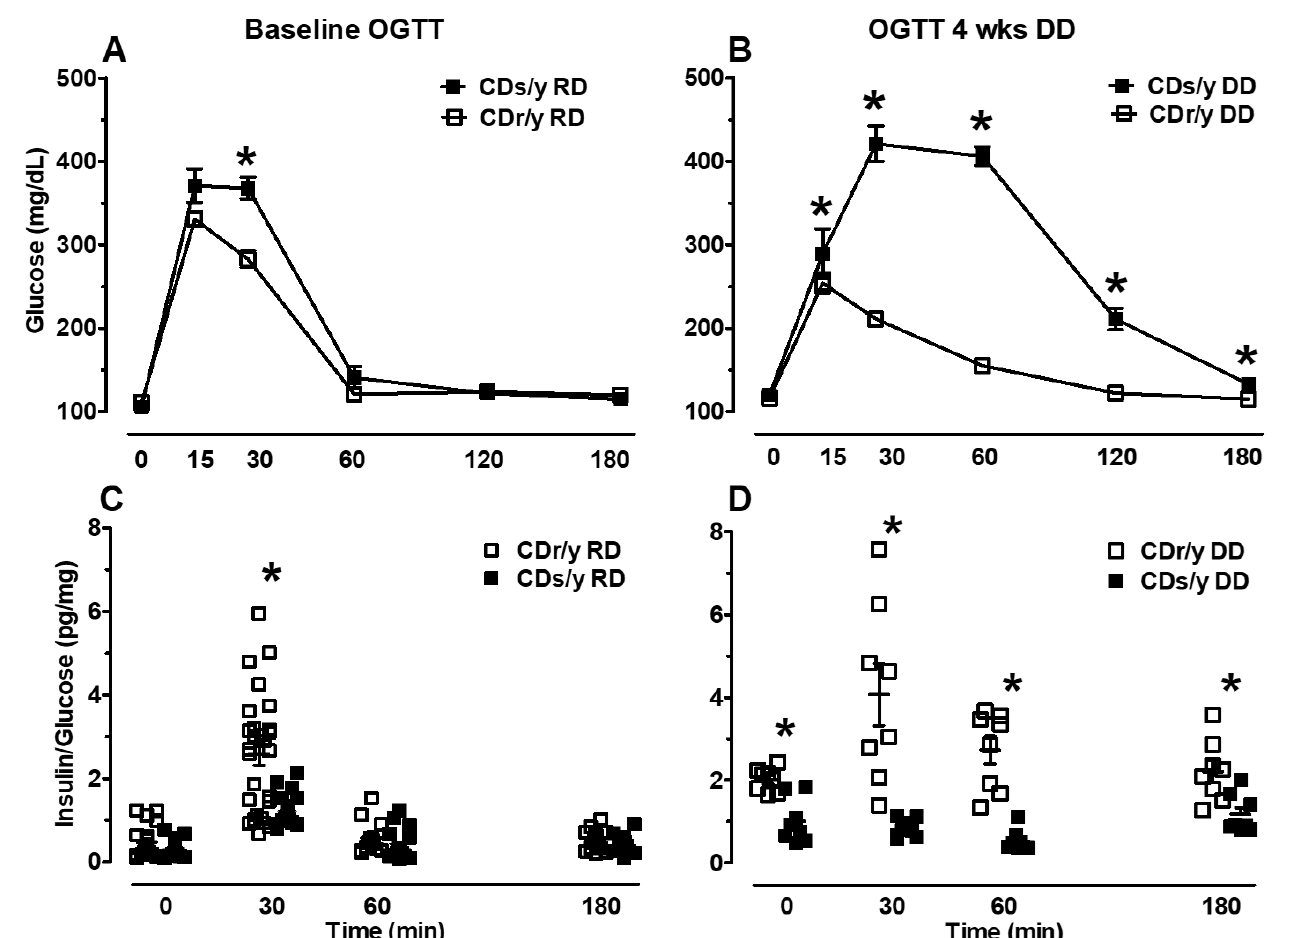
Figure 4. The results of an oral glucose tolerance test (OGTT): Glucose levels in CDs/y and CDr/y (panel A ) at baseline while fed RD ( n = 9 and n = 10, respectively), and (panel B ) after 4 weeks of DD ( n = 14 and n = 14, respectively)–data are shown as average ± SEM; insulin/glucose ratio in CDs/y and CDr/y (panel C ) at baseline while fed RD ( n = 13–27 and n = 16–25, respectively) and (panel D ) after 4 weeks of DD ( n = 8 and n = 8, respectively)–data are shown as scattergrams. Between group (CDs/y vs. CDr/y) analysis at each time point was by two-tailed Student’s t -test, * p < 0.01.